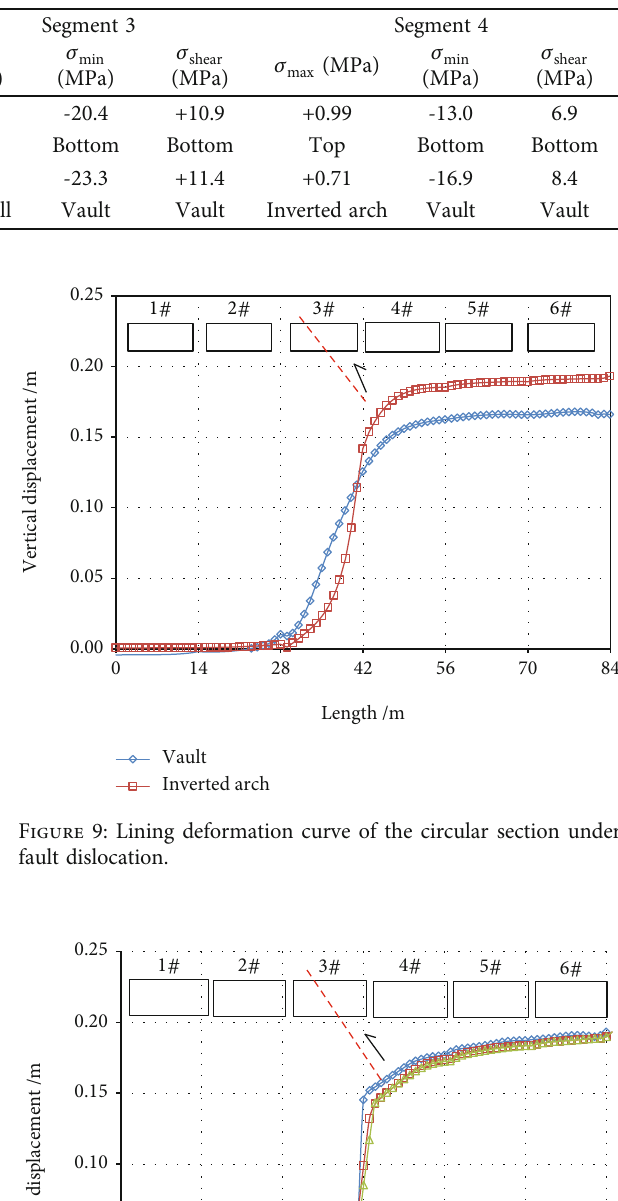
Table 3: Comparison of lining stress between circular and horseshoe section shapes.